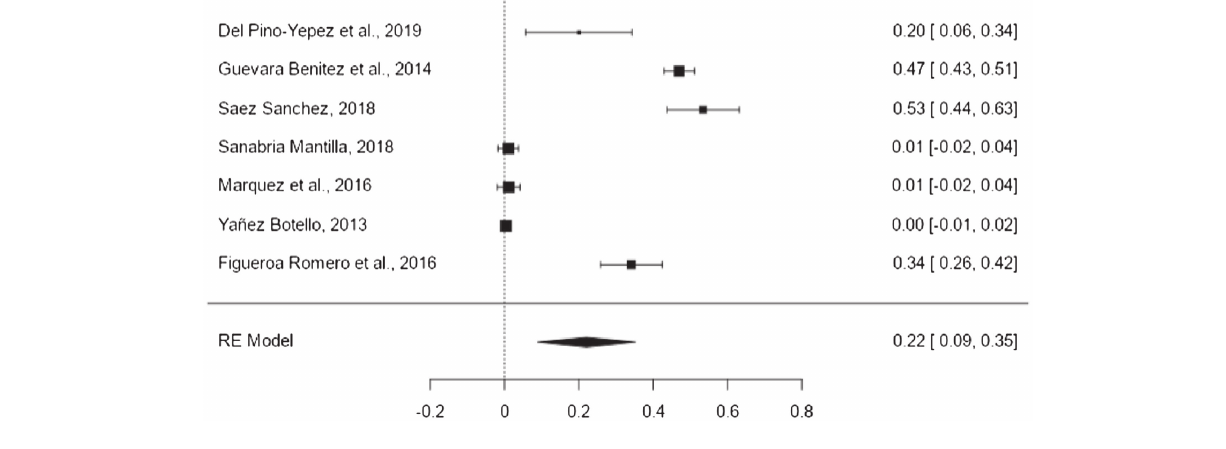
FIGURE 4 | Forest plot of critical